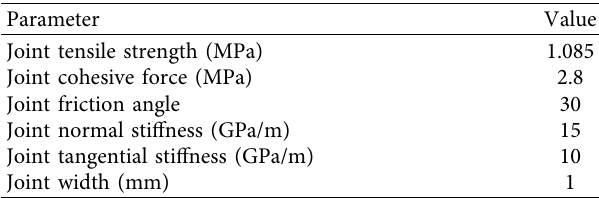
Figure 4: Stress-strain curves of rocks with different joint cross- Table 2: Meso-parameters for the SJM [11].